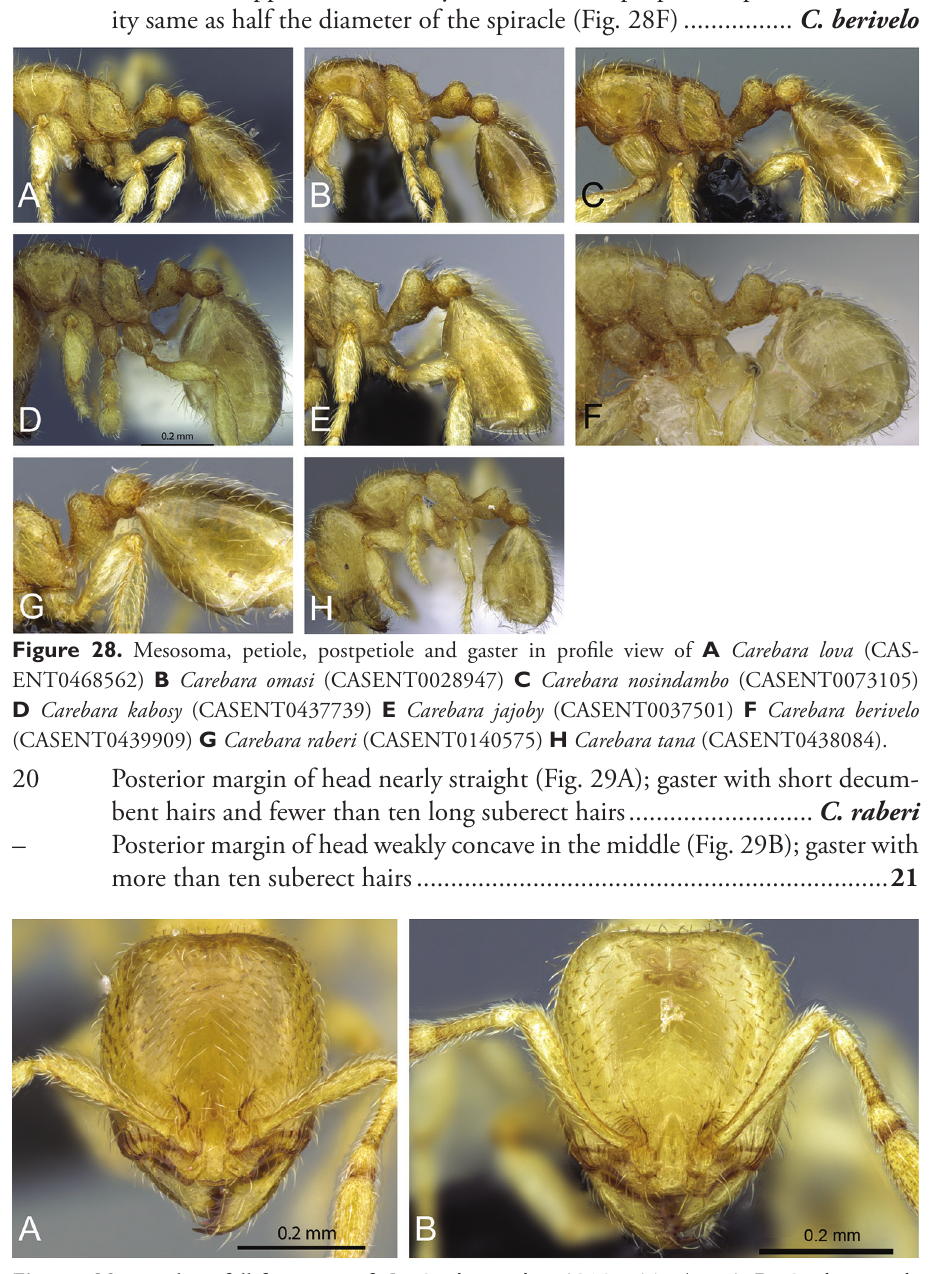
Figure 29. Head in full-face view of A Carebara raberi (CASENT0140575) B Carebara jajoby